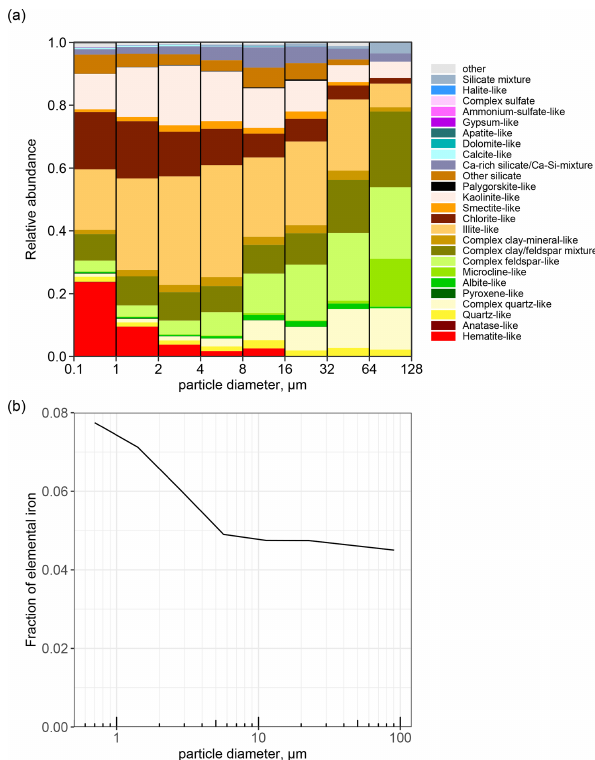
Figure 9. (a) Relative contribution of each particle type to total iron and (b) fraction of elemental iron by mass with respect to all the other